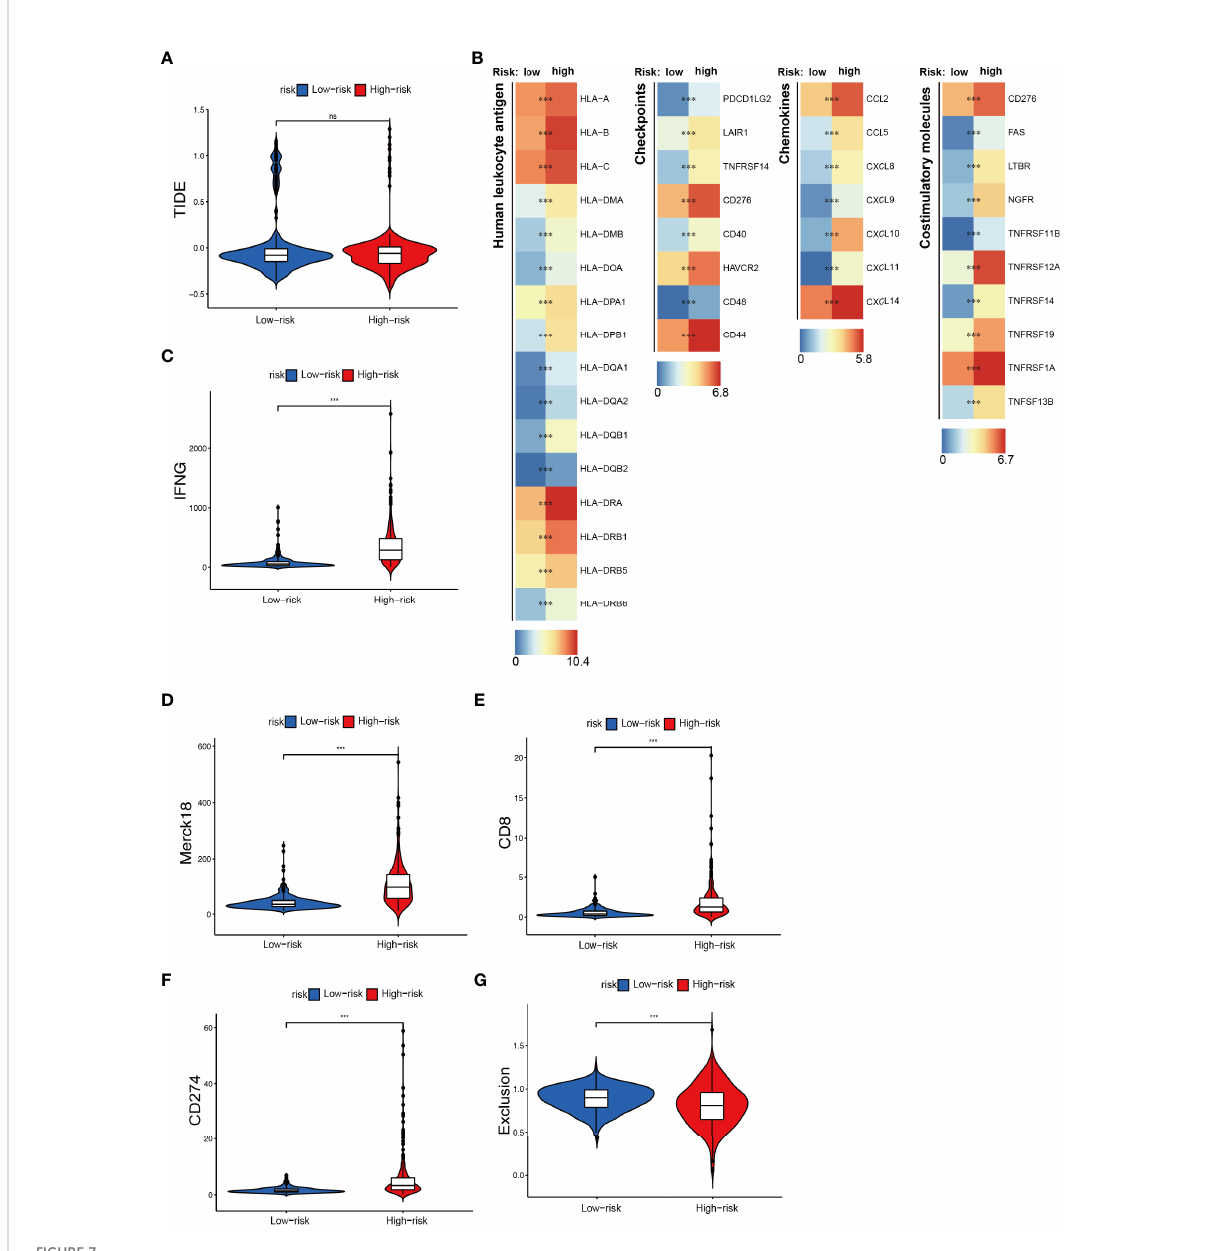
FIGURE 7 Immunotherapeutic responses exploration between NRS groups. (A) The TIDE score in NRS groups. (B) Expression of different immune-related indexes between NRS groups. (C – G) The expression differences of IFNG, CD8, CD274, and different Exclusion and Merck18 score between NRS groups. *** p<0.001; ns, no signi fi